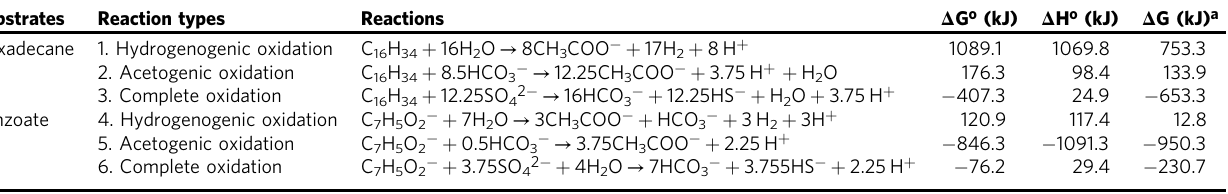
Table 2 Thermodynamic parameters and Gibbs free energies for anaerobic benzoate and hexadecane degradation scenarios Substrates Reaction